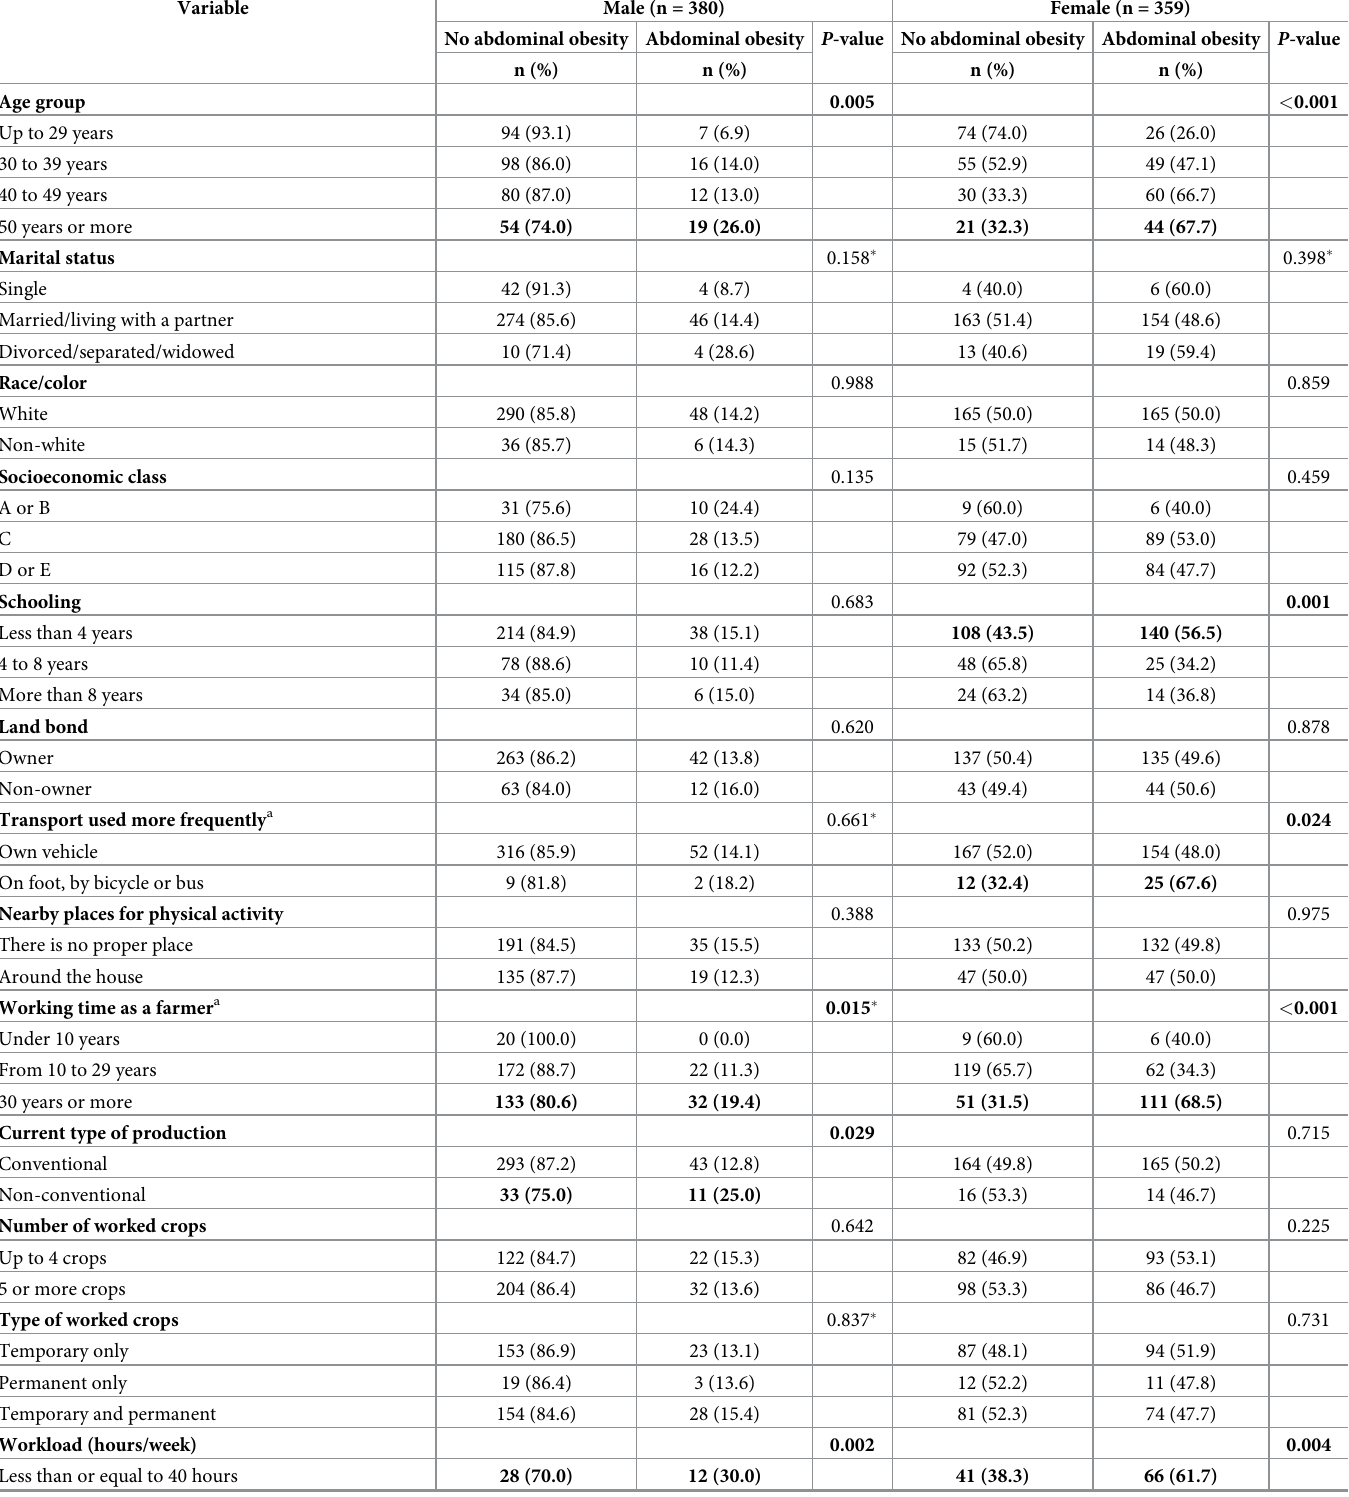
Table 4. Abdominal obesity and sociodemographic, labor, lifestyle and dietary pattern variables of a rural Brazilian population, according to sex.